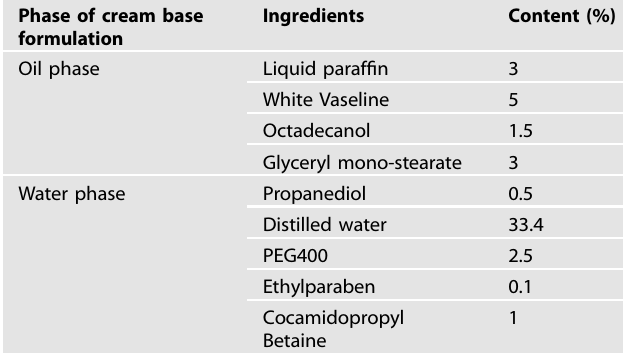
Table 1. The formulation of TC13172 solution (0.25%).